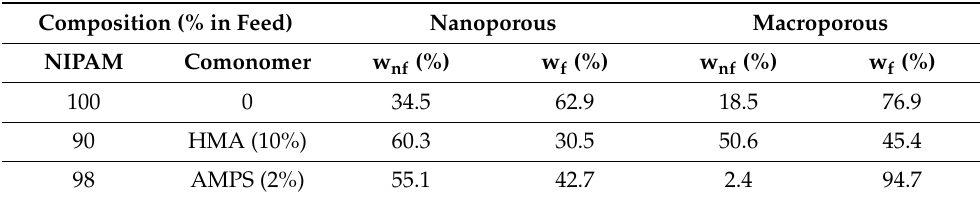
Table 2. Effect of copolymer composition and fabrication method on the amount of freezing and nonfreezing water (measured by